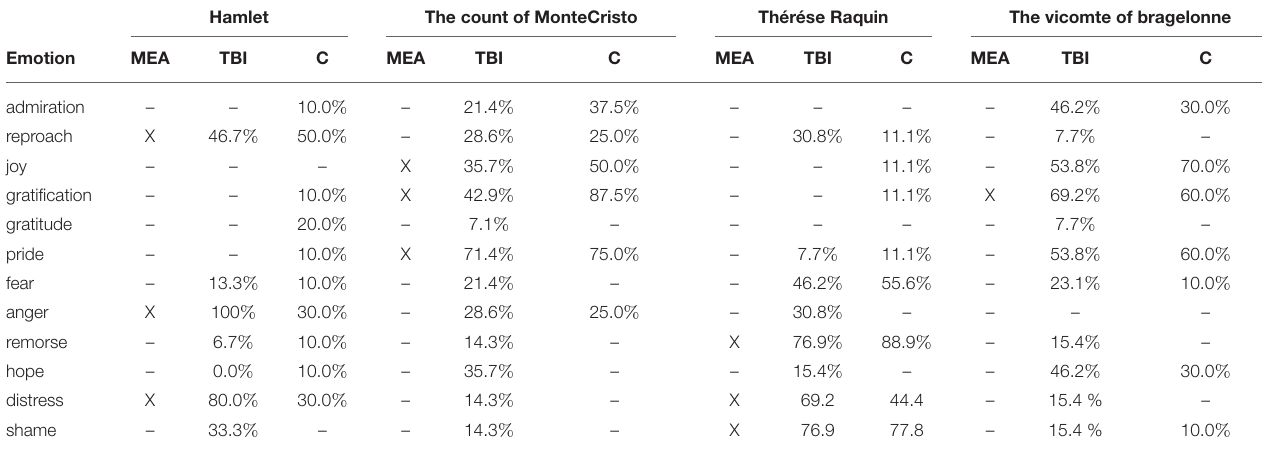
TABLE 6 | Audience studio: percentages for emotion choice (Main character). Hamlet